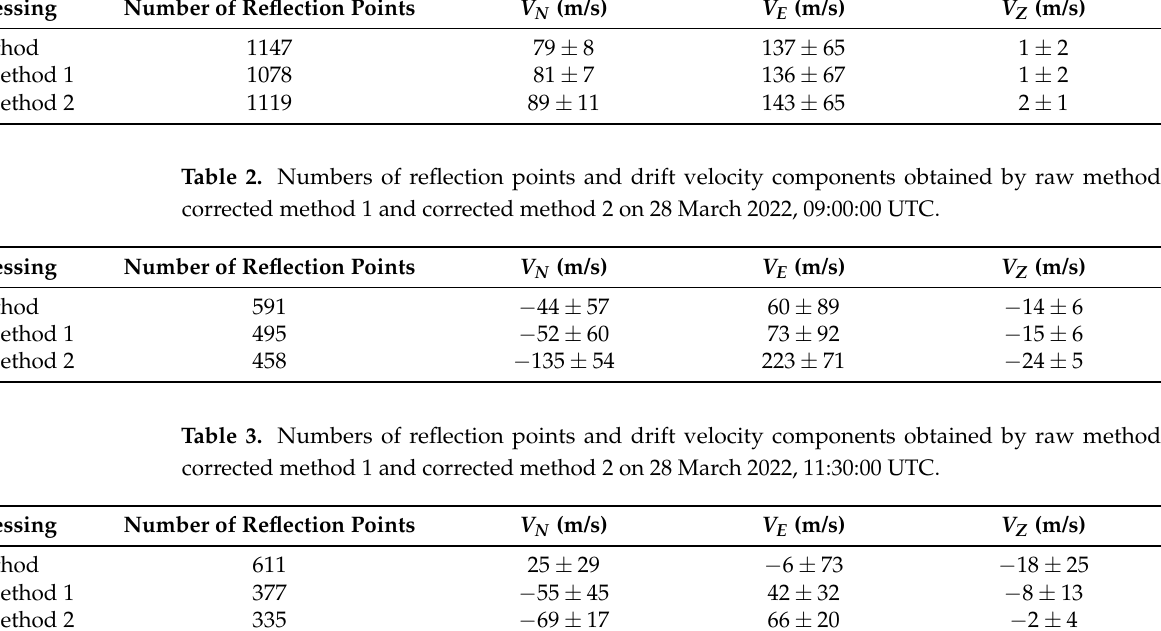
Table 1. Numbers of reflection points and drift velocity components obtained by raw method,